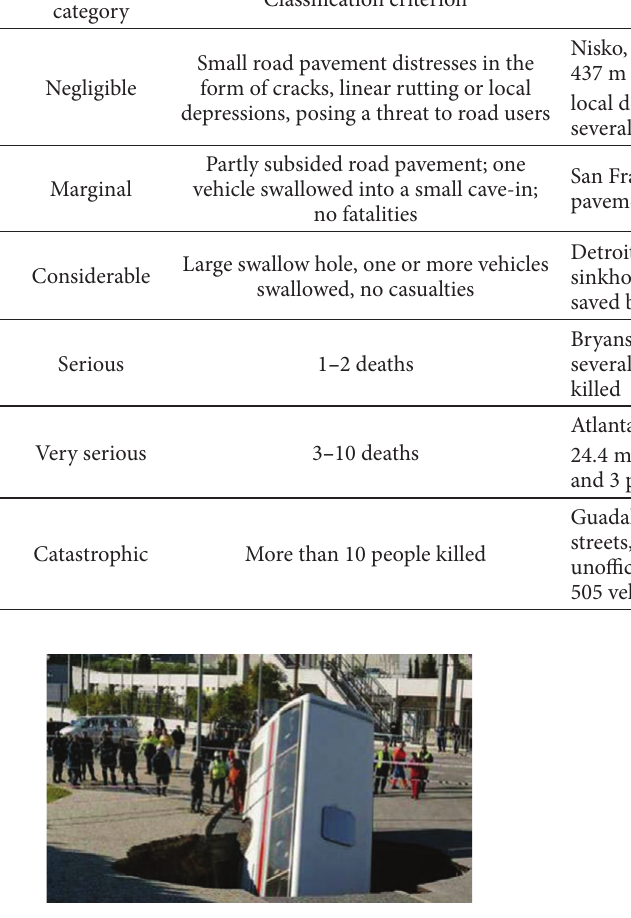
Table 1. Categories of road pavement collapses, according to the number of fatalities Failure Classification criterion category